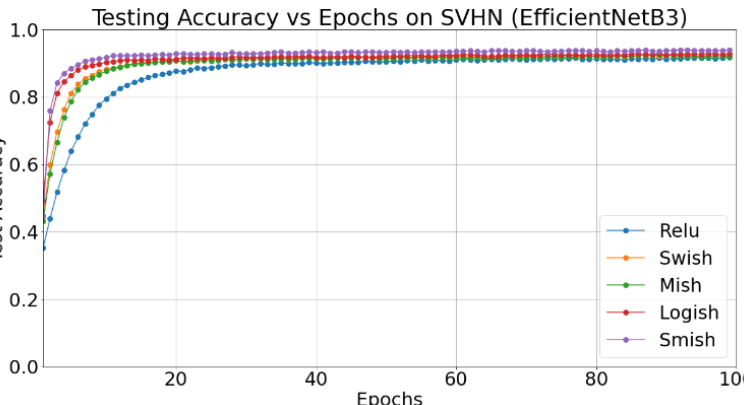
Figure 13. Accuracy vs. epochs in EfficientNetB3 achieved via the five activation functions on SVHN.